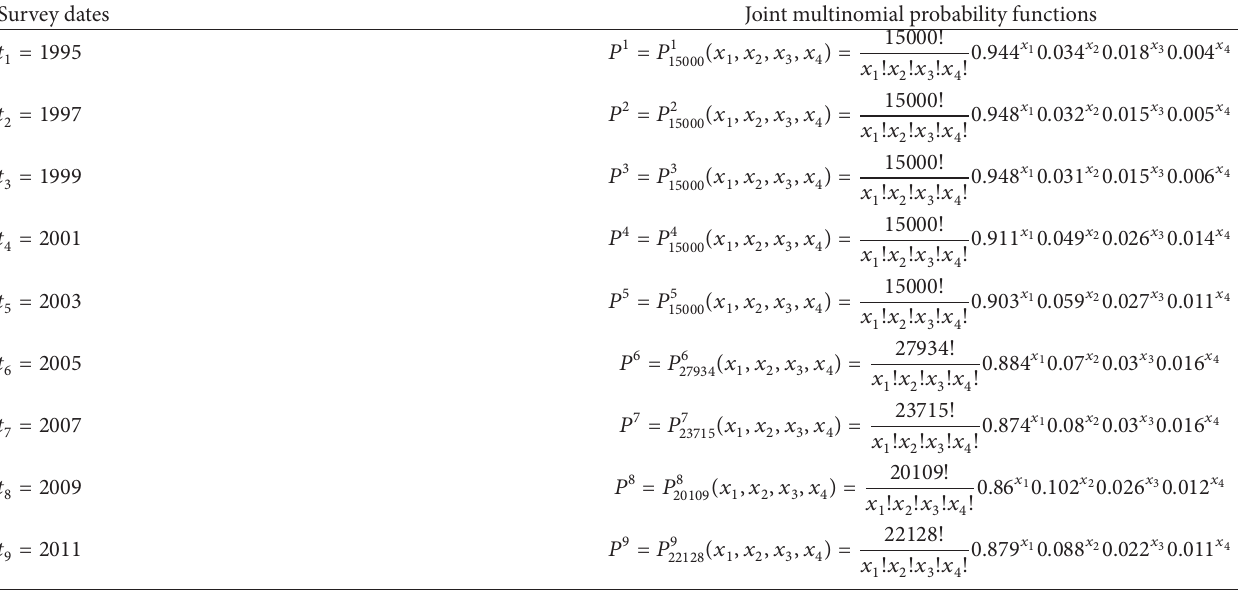
Table 2: Date and data joint multinomial probability function of each survey.